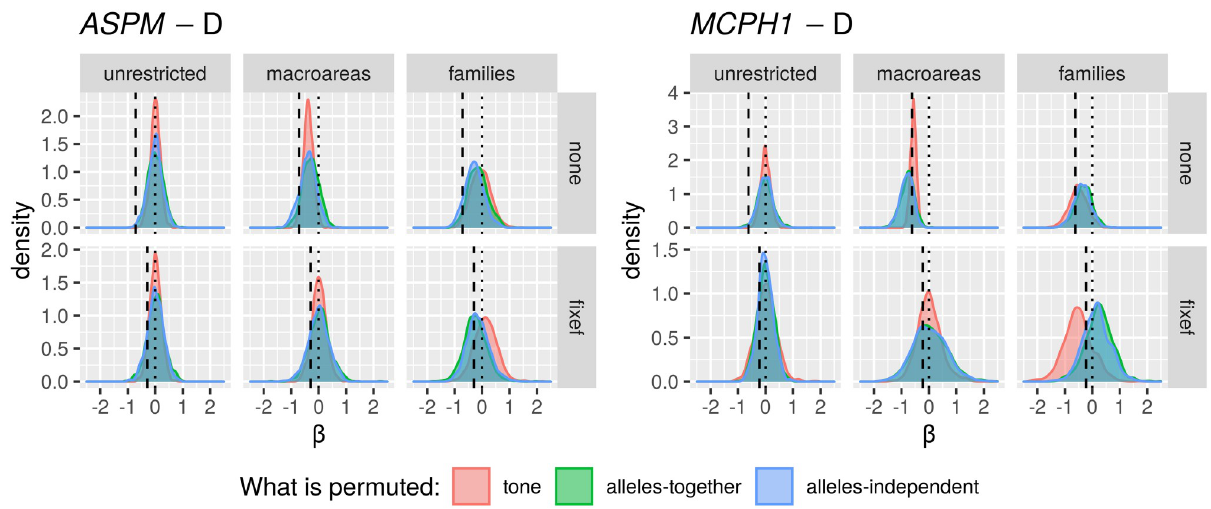
Fig 9. Distribution of the effect size β (horizontal axis) of ASPM -D (left) and MCPH1 -D (right) on tone1 in the permutation regressions without restrictions (“unrestricted”), only within macroareas (“macroareas”), and only within families (“families”), without controlling for macroarea (“none”) or when including macroarea as a fixed effect (“fixef”). Each individual plot shows the original β obtained on the unpermuted data (vertical dashed black line), 0.0 (vertical dotted black thin line), and the distribution of the permuted β for the three variables to be permuted (the coloured areas): tone by itself (red), the two “derived” alleles together as a unit (green), and the two “derived” alleles shuffled individually (blue). Please note that the y-axes vary between plots, but the x-axes are fixed for comparability. If a distribution is centred on 0.0 (e.g., “ASPM”/“unrestricted”/“none” in the top left) then the permuted data show no effect of the “derived” allele (here, ASPM -D) on tone (i.e., the regression slope β is 0.0). The less overlap is between the observed β (dashed black line) and such a distribution, the more “special” the relationship between the “derived” allele and tone is relative to the structure destroyed by that specific permutation; conversely, if the observed β is largely included in a distribution, the more such a value is expected by chance given the constraints of the permutation.